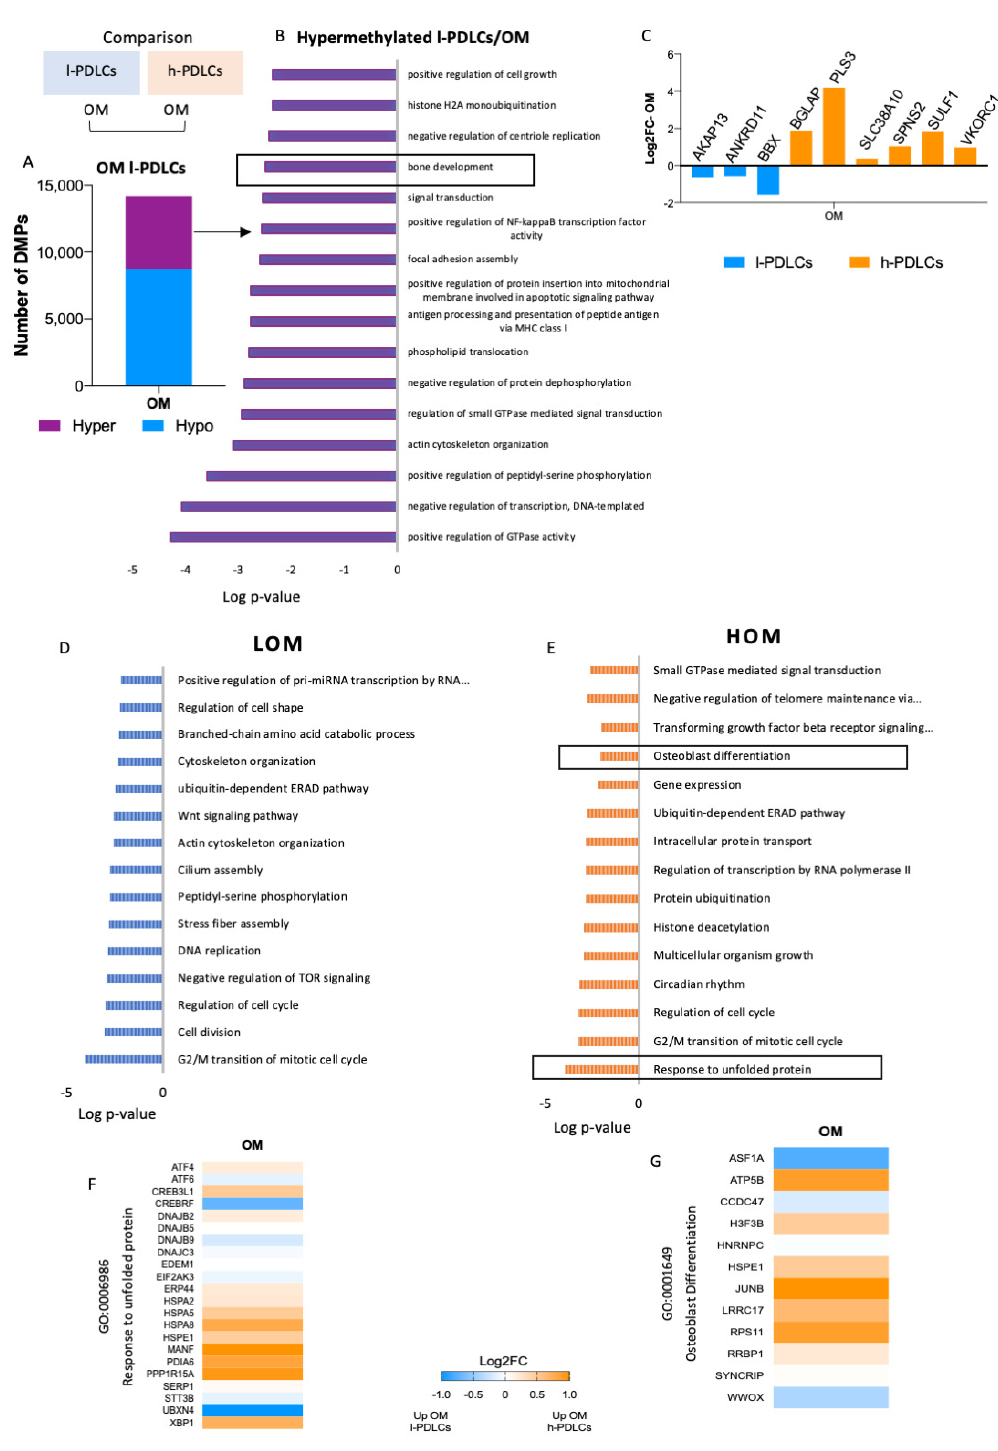
Figure 6. DNA methylation and open chromatin regions in PDLCs with distinct osteogenic potential after osteogenic stimulation. The comparison of l- and h-PDLCs at epigenetic levels (DNA methy- lation and chromatin accessibility) was performed between data sets obtained after 10 days of cell culture in OM media. ( A ) Proportion of 14,194 differentially methylated probes, either hypo- or hyper-methylated in l-PDLCs as compared to h-PDLCs. ( B ) The top 16 biological processes related to genes hypermethylated in l-PDLCs. ( C ) Gene expression changes related to ‘Bone development’ pro- cess highlighted in ( B ), extracted from the RNA-seq data as Log2FoldChange. ( D , E ) Open chromatin regions identified by ATAC-seq after osteogenic stimulation were linked to the closest gene, and